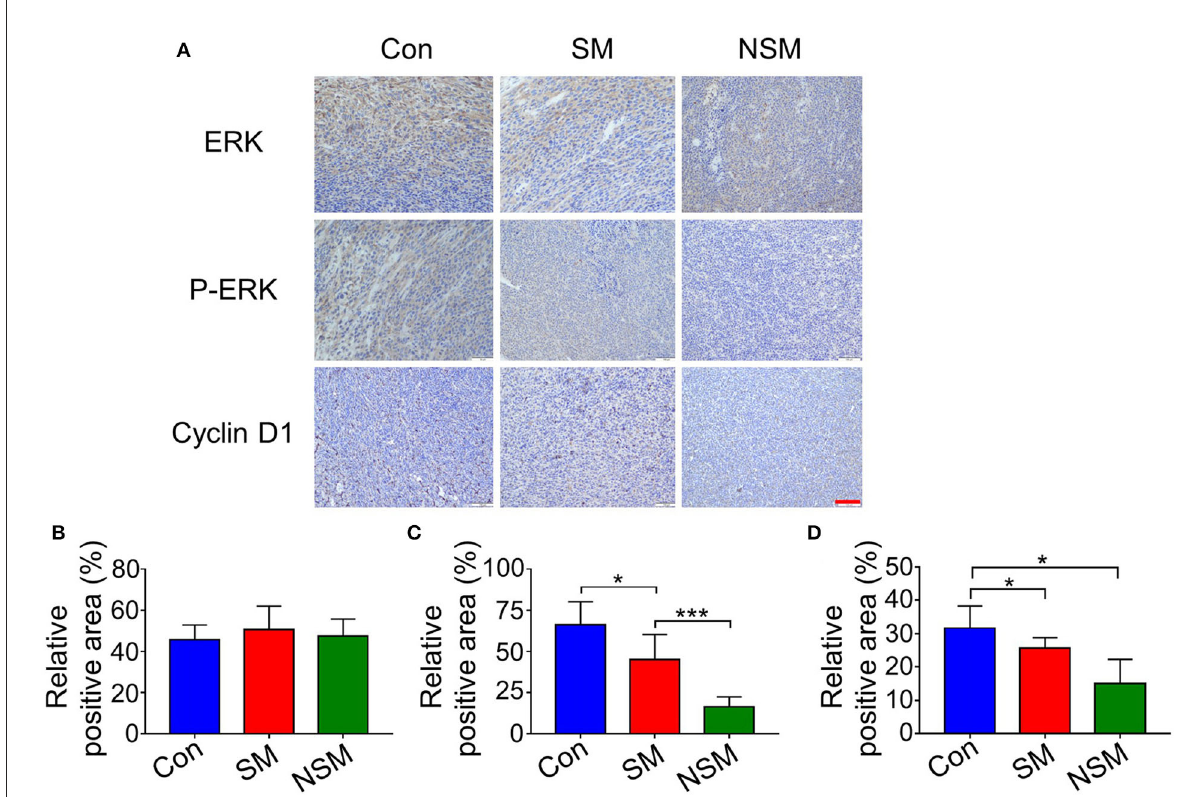
FIGURE7 Immunohistochemical analyses of tumor tissues. (A) Immunohistochemical staining of ERK, p-ERK, and Cyclin-D1 in tumor tissues. Relative positive areas of (B) ERK, (C) p-ERK, and (D) Cyclin-D1. Scale bar = 100 µ m. * and *** represent P < 0.05 and P < 0.001, respectively.